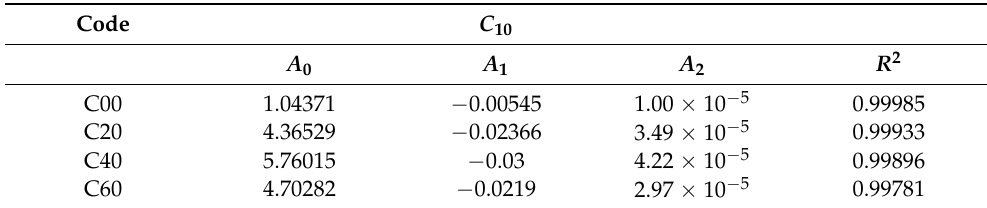
Table 4. Temperature-dependent characterization parameters of the model parameter C 10 for four types of rubbers.